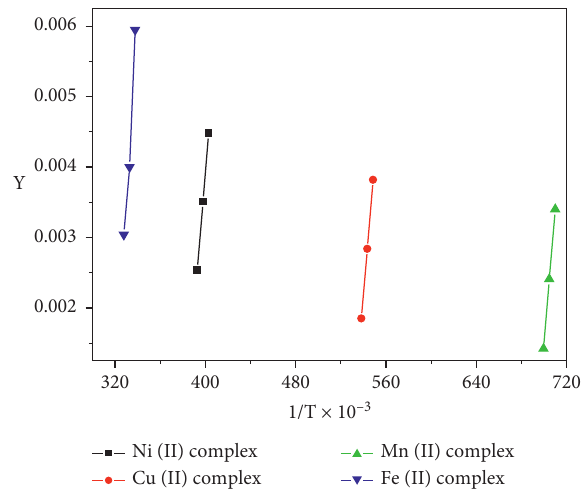
Figure 6: Coats–Redfern plot for the complex 2 nd step in dynamic air.